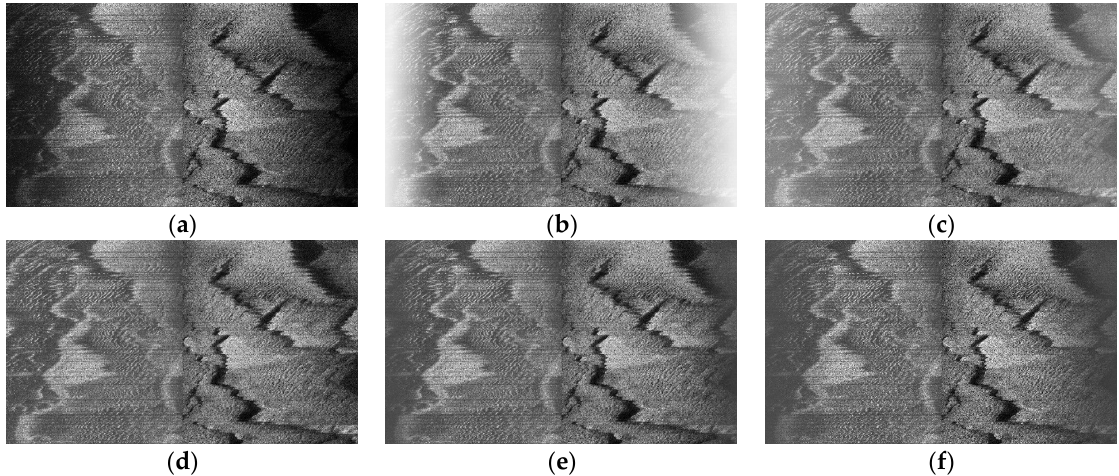
Figure 11. TVG correction performance comparison. ( a ) Raw data. ( b ) A = 30, B = 20. ( c ) A = 15, B = 10. ( d ) A = 5, B = 3.1. ( e ) A = 4, B = 3. ( f ) A = 2, B =